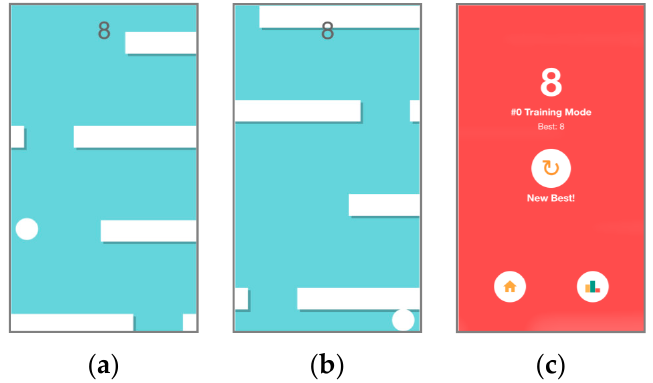
Figure 10. Screenshots of the game: ( a ) Ball avoiding the obstacles; ( b ) Ball being dragged down due to the collision with an obstacle; ( c ) Game lost.